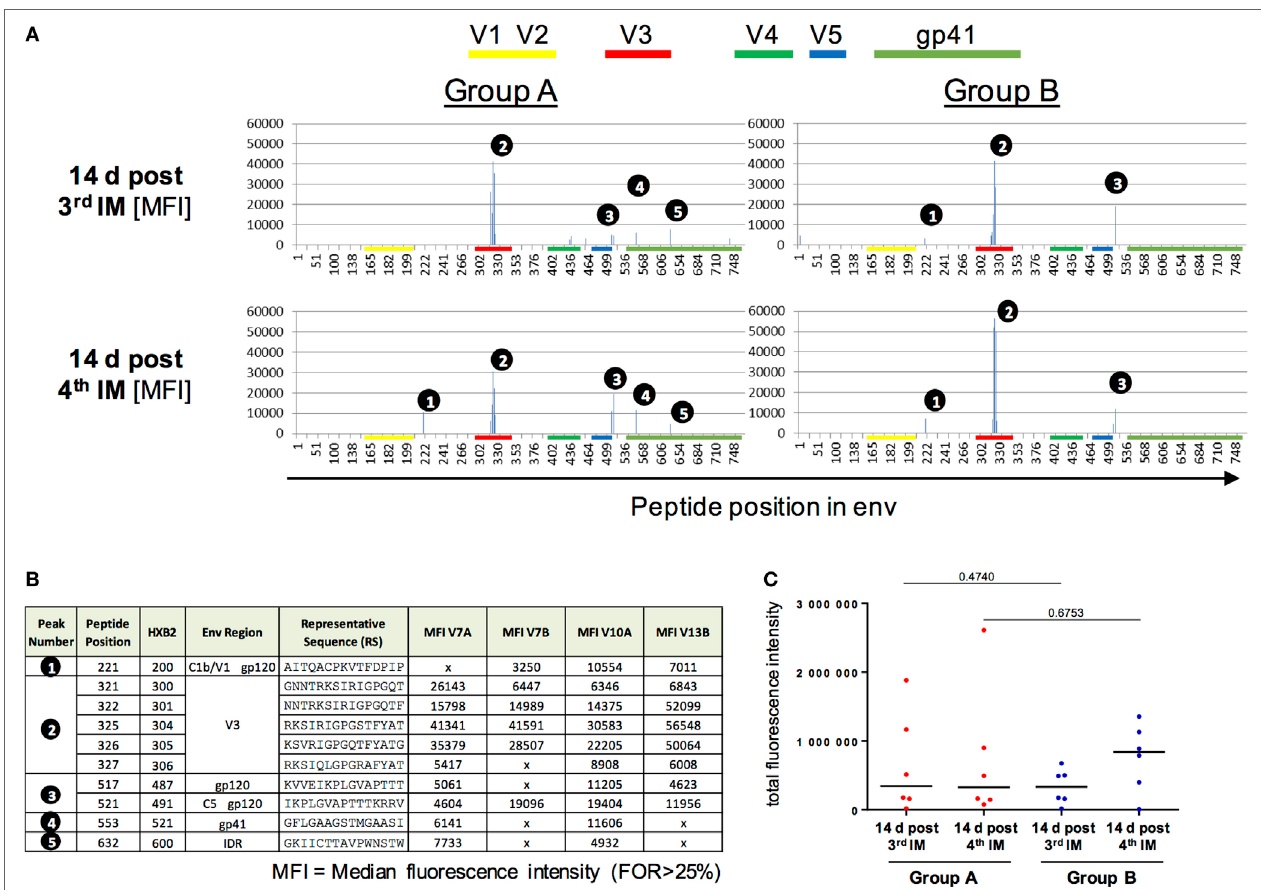
FiGUre 4 | Peptide array analysis of env-specific igG responses . (a,B) Specificity of serum IgG responses at 14 days after the third and fourth intramuscular immunization (IM) for Group A and B. Shown is the median fluorescence intensity (MFI). IgG responses against individual antigenic regions were considered positive if the corresponding fluorescence intensity was above 2,500 after subtraction of the prevaccination value (D0). The MFI was then calculated for region-specific IgG responses occurring in at least 25% of vaccines. (C) Comparison of total fluorescence intensity of ENV-specific serum antibodies 4 days post third/fourth IM for Group A and B showed no significant differences (Mann–Whitney